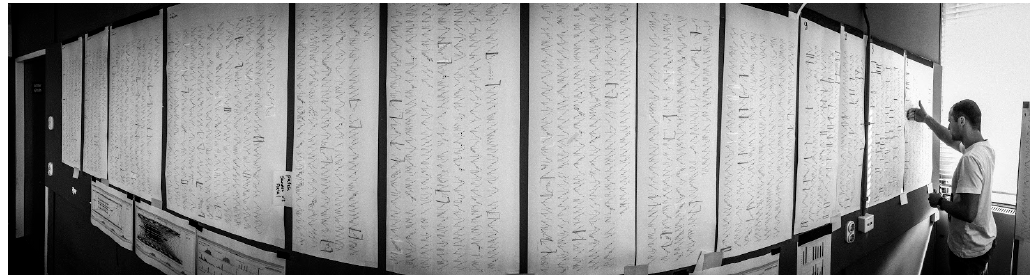
Figure 8. The initial analysis of the data of the Social Stairs EDL at the Eindhoven University of Technology. Each sheet represents one day of data. This figure shows 13 days out of the total 6 months of data.